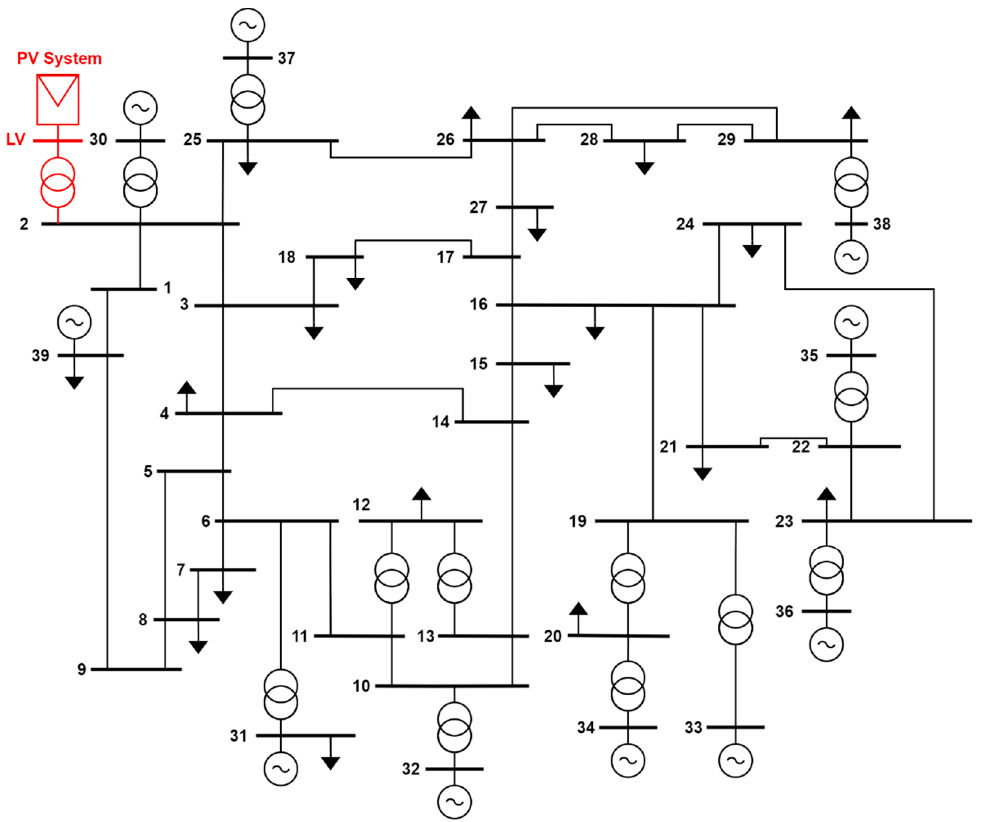
Figure 1. Single Line Diagram of IEEE 39 Modified Bus [30,31].